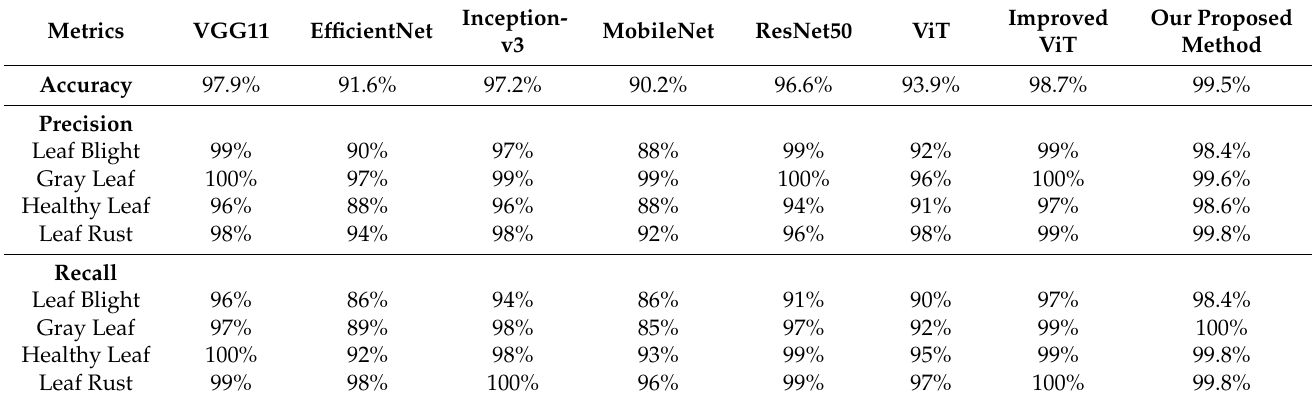
Table 2. Comparison of three metrics to the results of other methods.